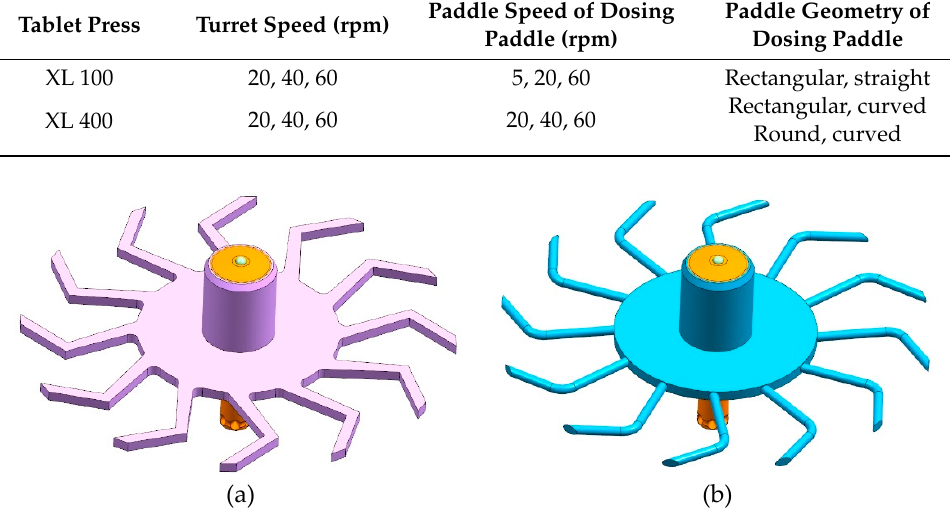
Table 2. Applied machine settings for RTD experiments on XL 100 and XL